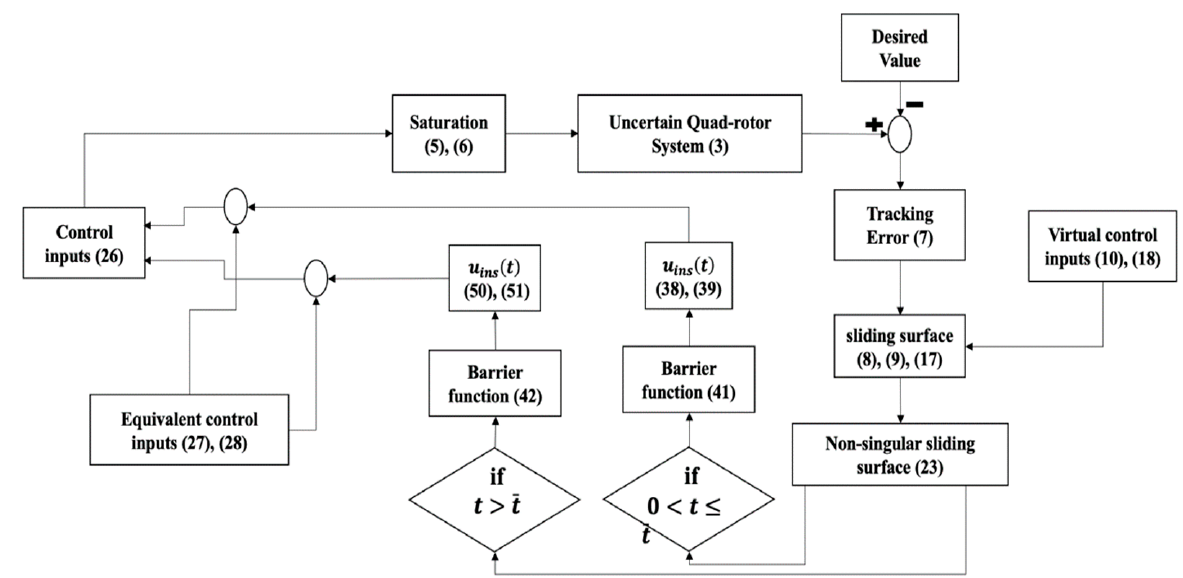
Figure 1. Block diagram of the proposed technique.